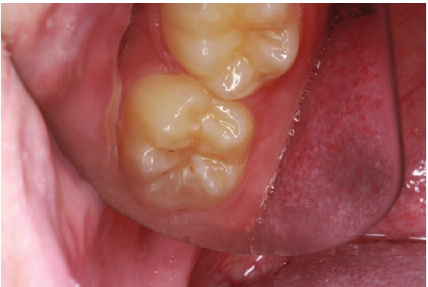
Figure 5: Postoperative clinical photograph of the lower right second molar.